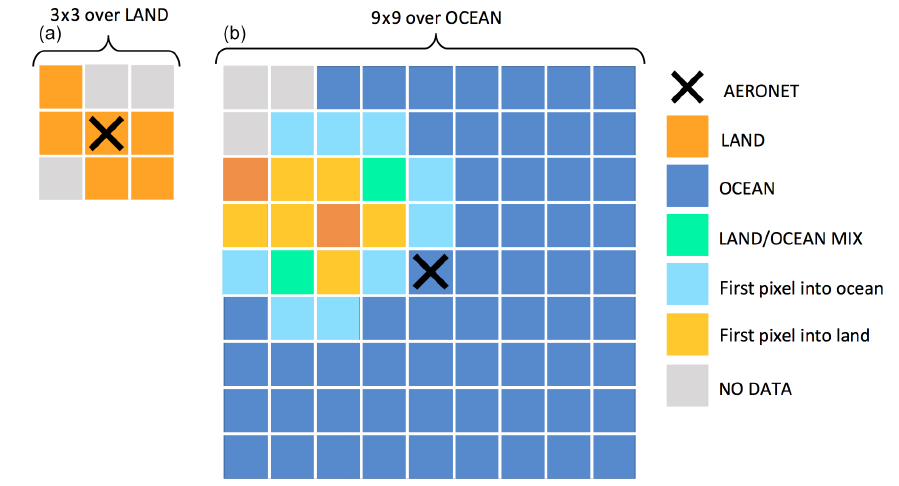
Figure 1. Schematic diagram for satellite data selection over (a) land and (b) ocean.